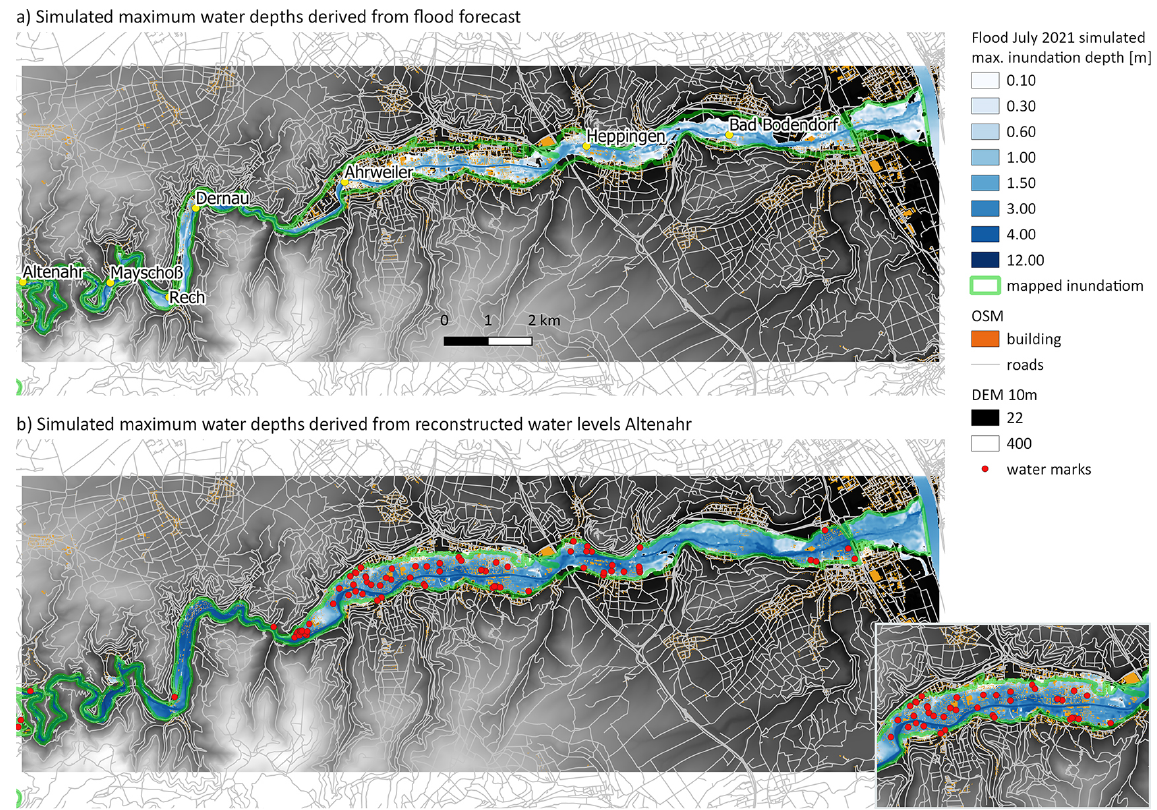
Figure 2. Maximum inundation depths during the flood in July 2021 simulated with RIM2D using (a) the water level forecast for the Altenahr gauge and (b) the reconstructed hydrograph of the event as shown in Fig. 1. The green outlined areas indicate the inundation areas mapped by the LfU of Rhineland-Palatinate. Data sources: DEM 10m resolution: © GeoBasis-DE/BKG 2012 (https://www.bkg.bund.de/, last access: 30 January 2022); OSM roads and buildings: © OpenStreetMap contributors 2021. Distributed under the Open Data Commons Open Database License (ODbL)